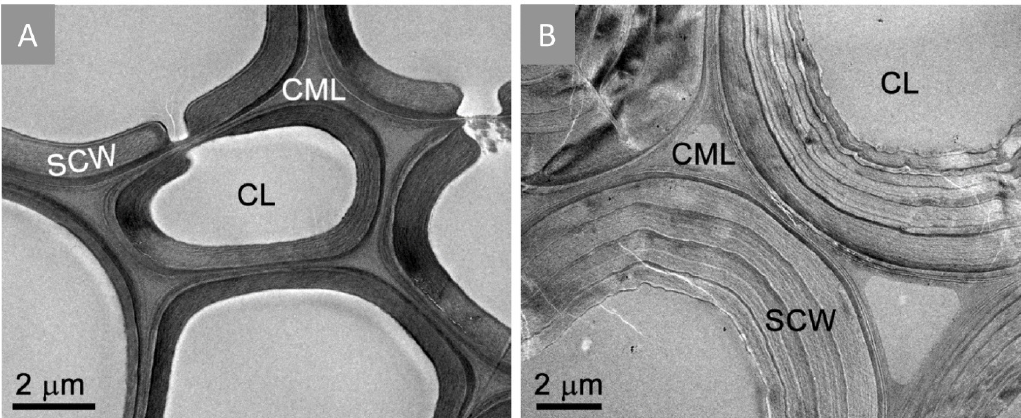
Figure 1. Transmission electron micrographs of native ( A ) and pretreated ( B ) corn stover cell walls. Pretreatment removed structural hemicelluloses and relocated lignin, which allowed for loosening and expansion of the cell wall. Annotations: SCW, secondary cell wall; CL, cell lumen; CML, compound middle lamella.